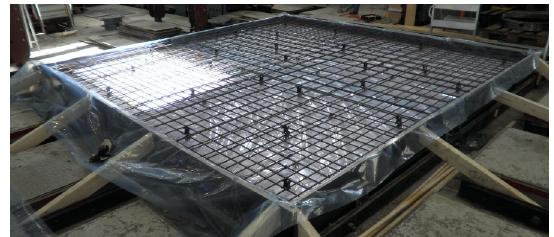
Figure 5. Casting frame and reinforcement arrangement [15].